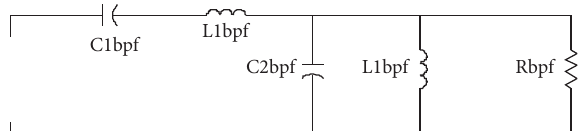
Figure 4: Chebyshev